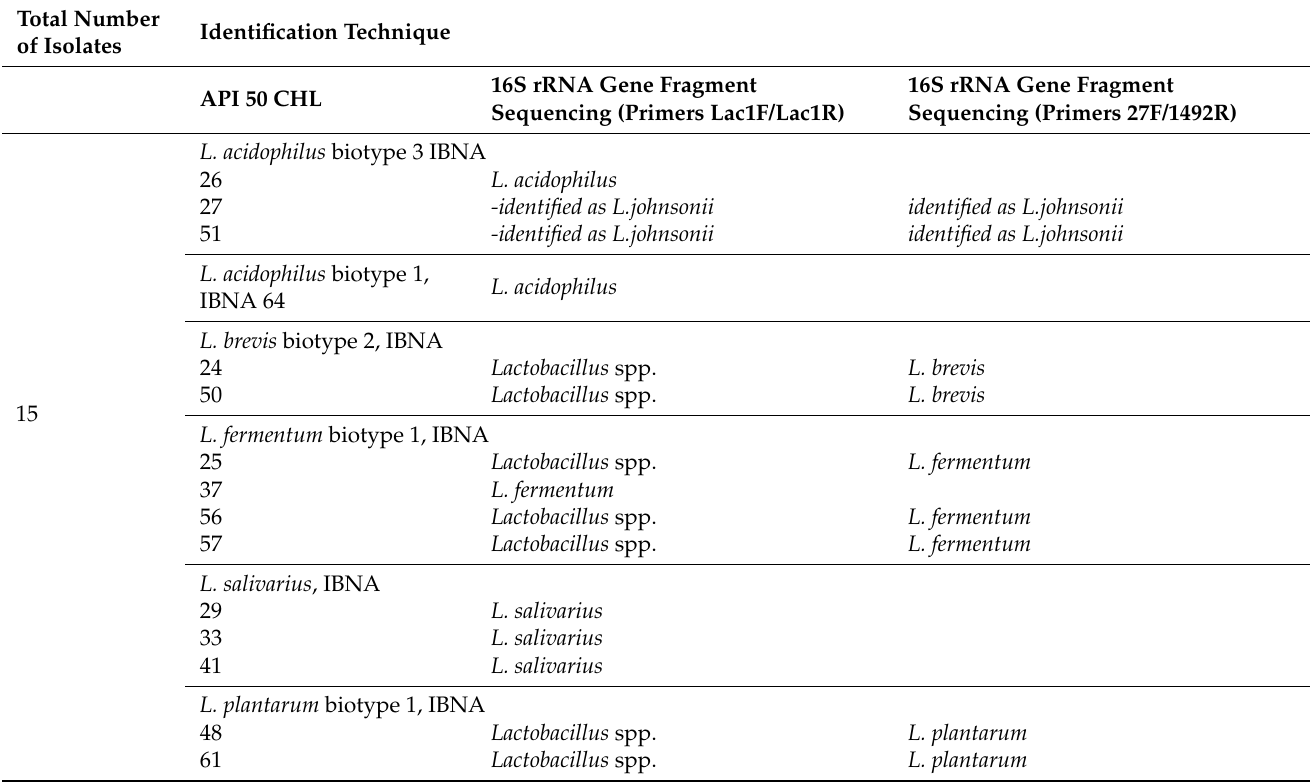
Table 2. Molecular identification of Lactobacillus strains from broiler chickens intestinal